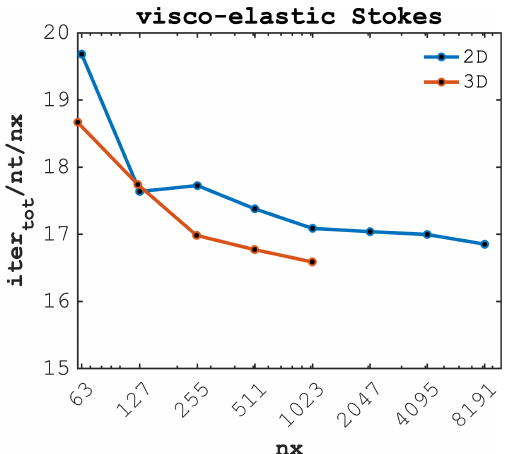
Figure 7. Iteration count scaled by the number of time steps ( n t ) and by the number of grid cells in the x direction ( n x ) as function of n x , comparing 2D and 3D visco-elastic Stokes flow containing an inclusion featuring a viscosity contrast ( µ 0 /µ i = 10 3